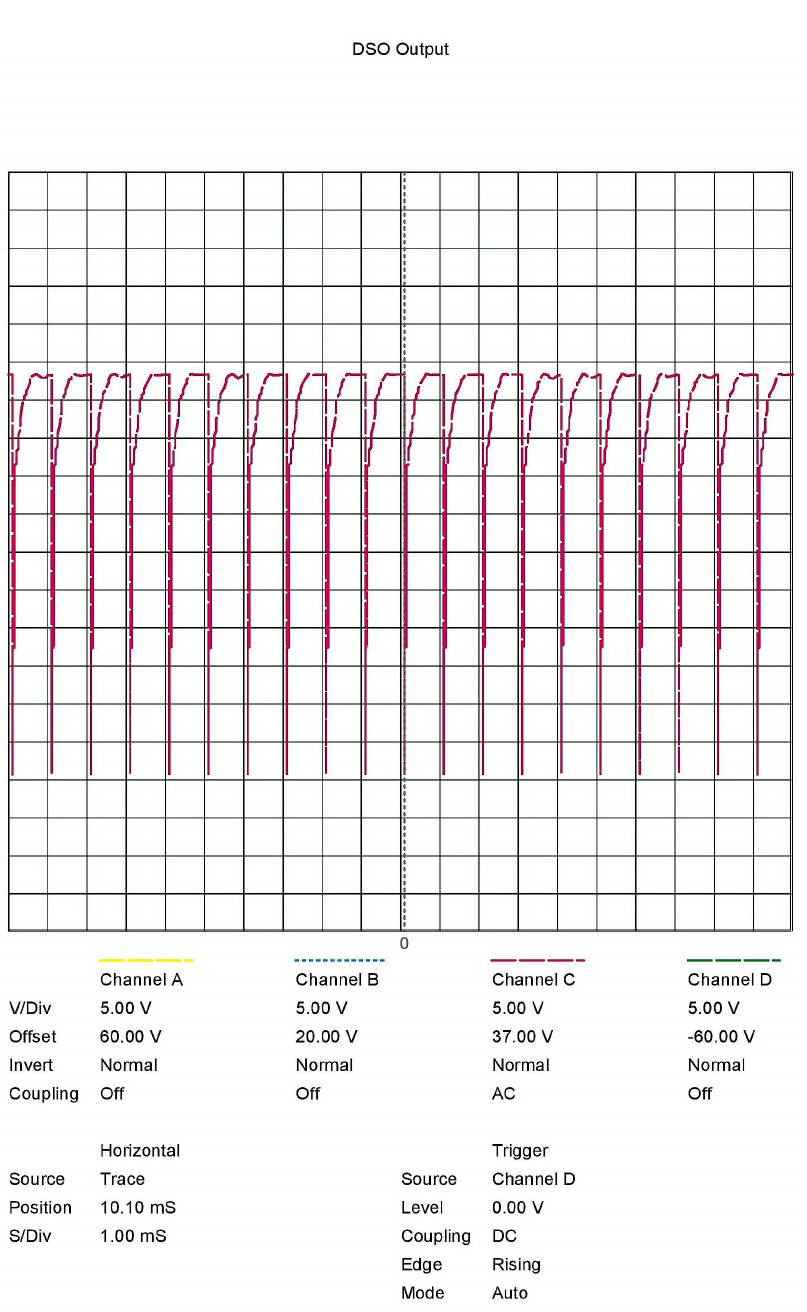
Figure 8. The pulses generated by the modified Marx